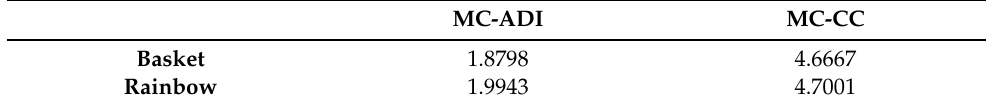
Figure 2. The value surface of basket and rainbow options at time t = 0, generated by the ADI method. Table 5. Comparison of the calculation time (in hours) of the two